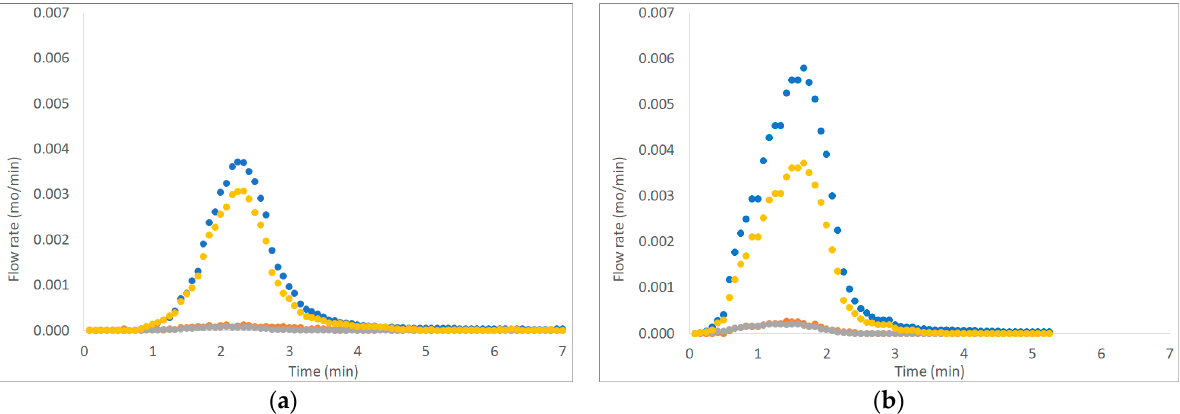
Figure 3. Example of H 2 , CO, CO 2 , and CH 4 outlet molar flow rates ( F i , out ) as functions of time ( t ), produced by devolatilization tests of ( a ) chirurgical masks and ( b ) FFP2 mask, in a fluidized